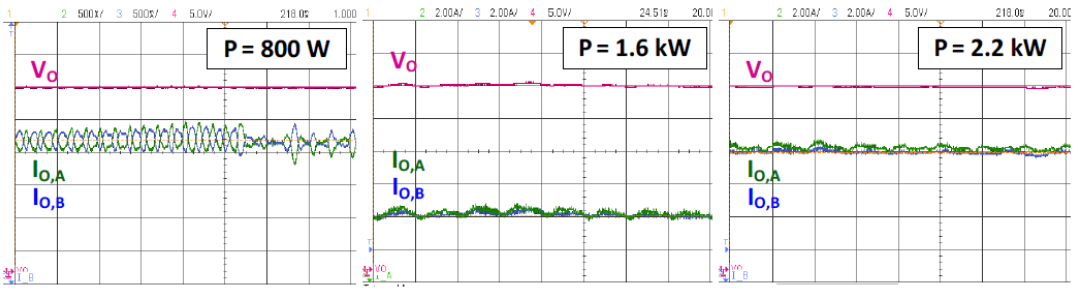
Figure 16. Experimental results under varying loads when using the current sharing parallel method.